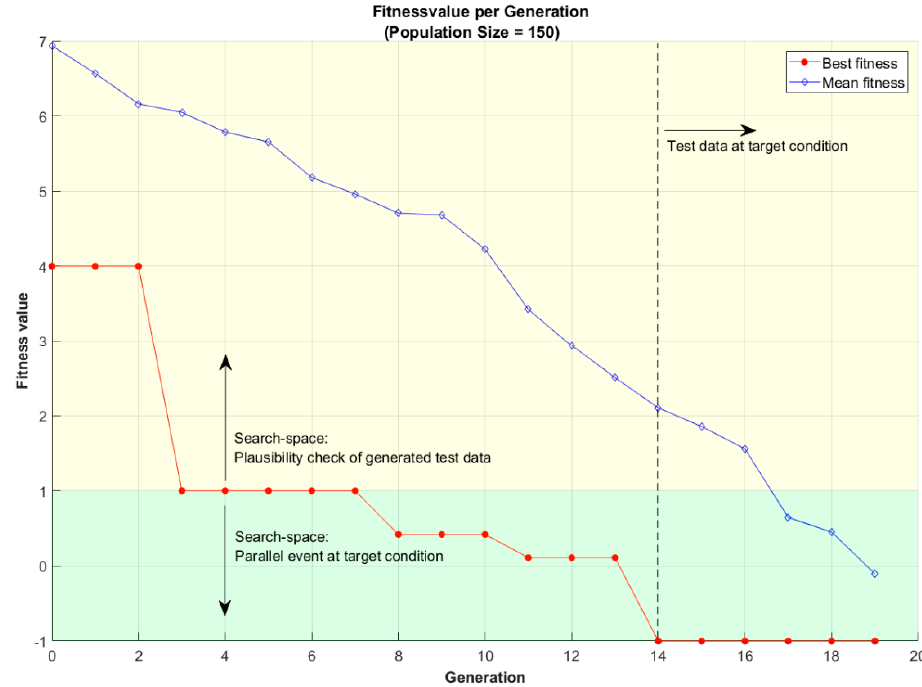
Figure 17. Case 2—Parallel event: best fitness value over generations.